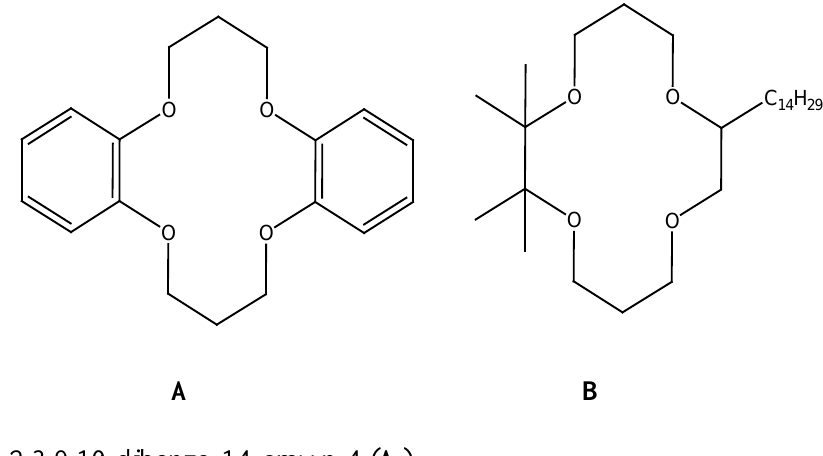
Figure 29. 2,3,9,10-dibenzo-14-crown-4 ( A ), 2,2,3,3-tetramethyl-9-tetradecyl-1,4,8,11-tetraoxatricyclo tetradecane (B